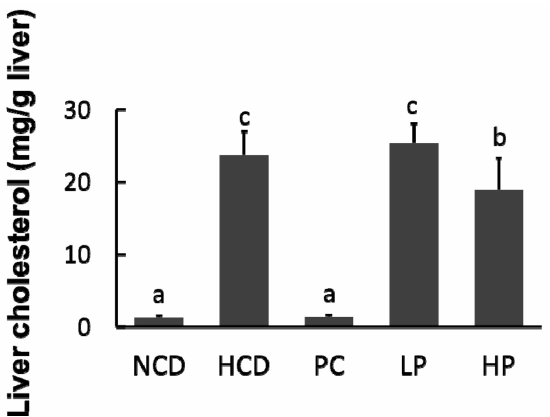
Figure 5. Changes in relative liver cholesterol concentration in hamsters fed one of five diets: NCD, no cholesterol diet; HCD, high cholesterol diet containing 0.1% cholesterol; PC, high cholesterol diet containing 0.5% cholestyramine; LP, high cholesterol diet containing a low dose (0.1%) soybean germ phytosterols (SGP); HP, high cholesterol diet containing a high dose (0.2%) of soybean germ phytosterols (SGP). n = 8 for each group. a,b,c = means with di ff erent superscript letters di ff er significantly at p <